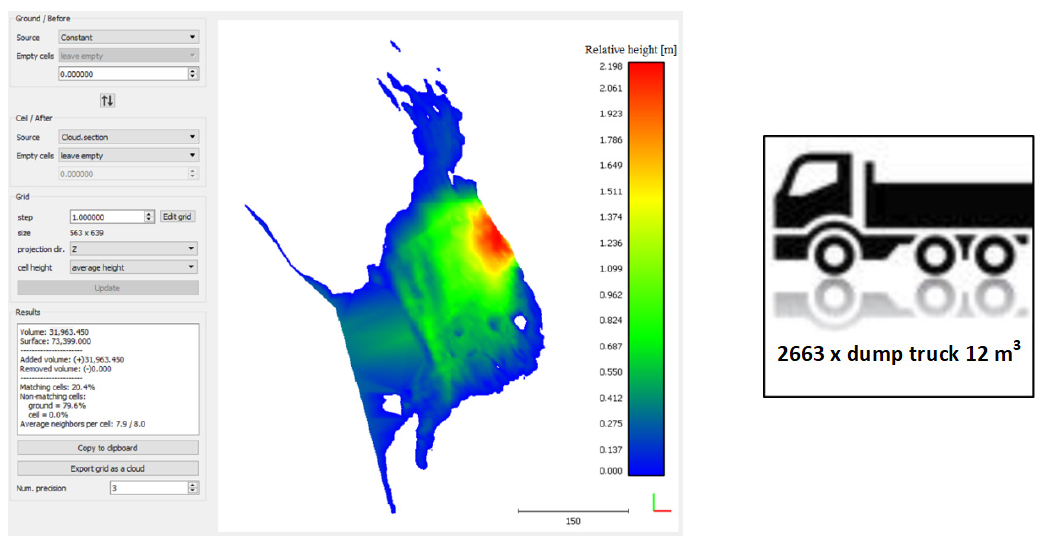
Figure 16. Map showing depth differences between tombolo digital terrain models (DTMs) developed on the basis of measurements and electronic navigational chart (ENC) data.